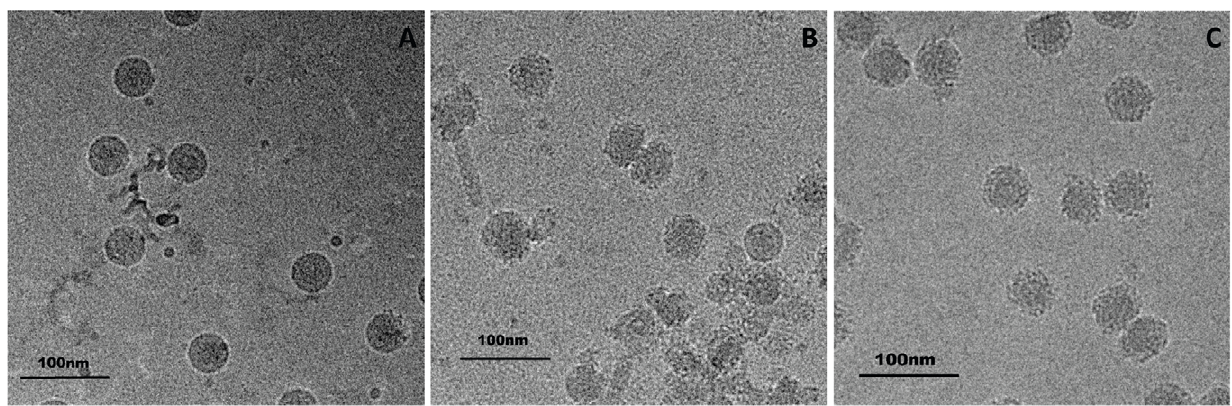
Figure 4. Cryoelectron microscopy. Purified and concentrated virus was prepared with or without incubation with peptides and then flash frozen for imaging. Panels show (A) virus only, (B) virus incubated with DN57opt, (C) virus incubated with 1OAN1. Scale bars indicate 100 nm.